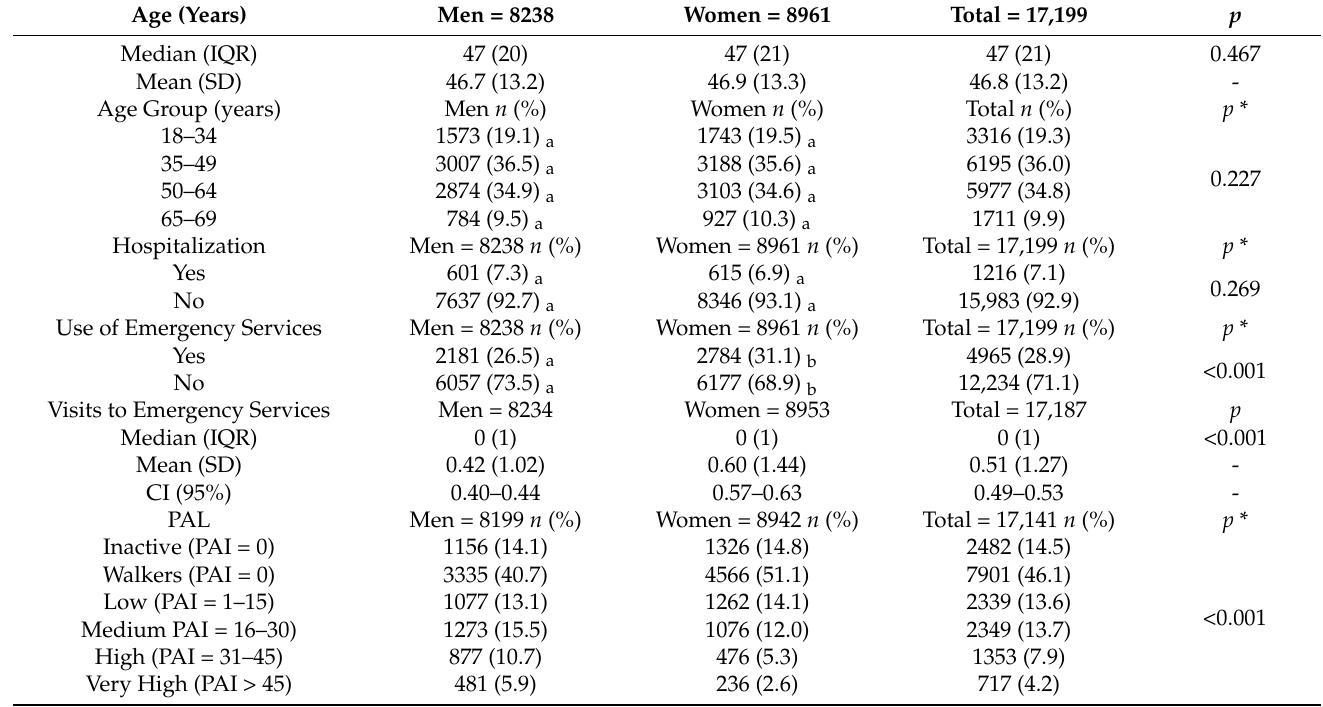
Table 1. Sociodemographic characteristics of the sample.